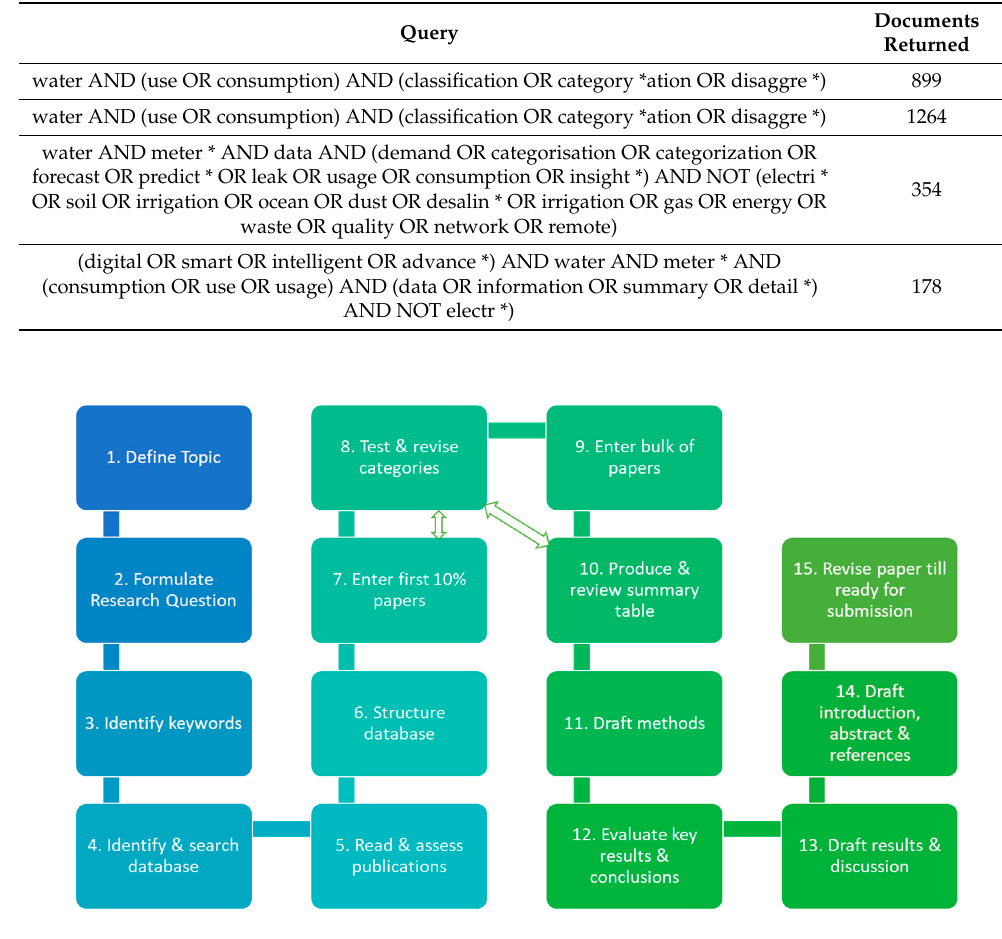
Figure 1. Steps followed to undertake a systematic quantitative literature review, as proposed by Pickering and Byrne [27]